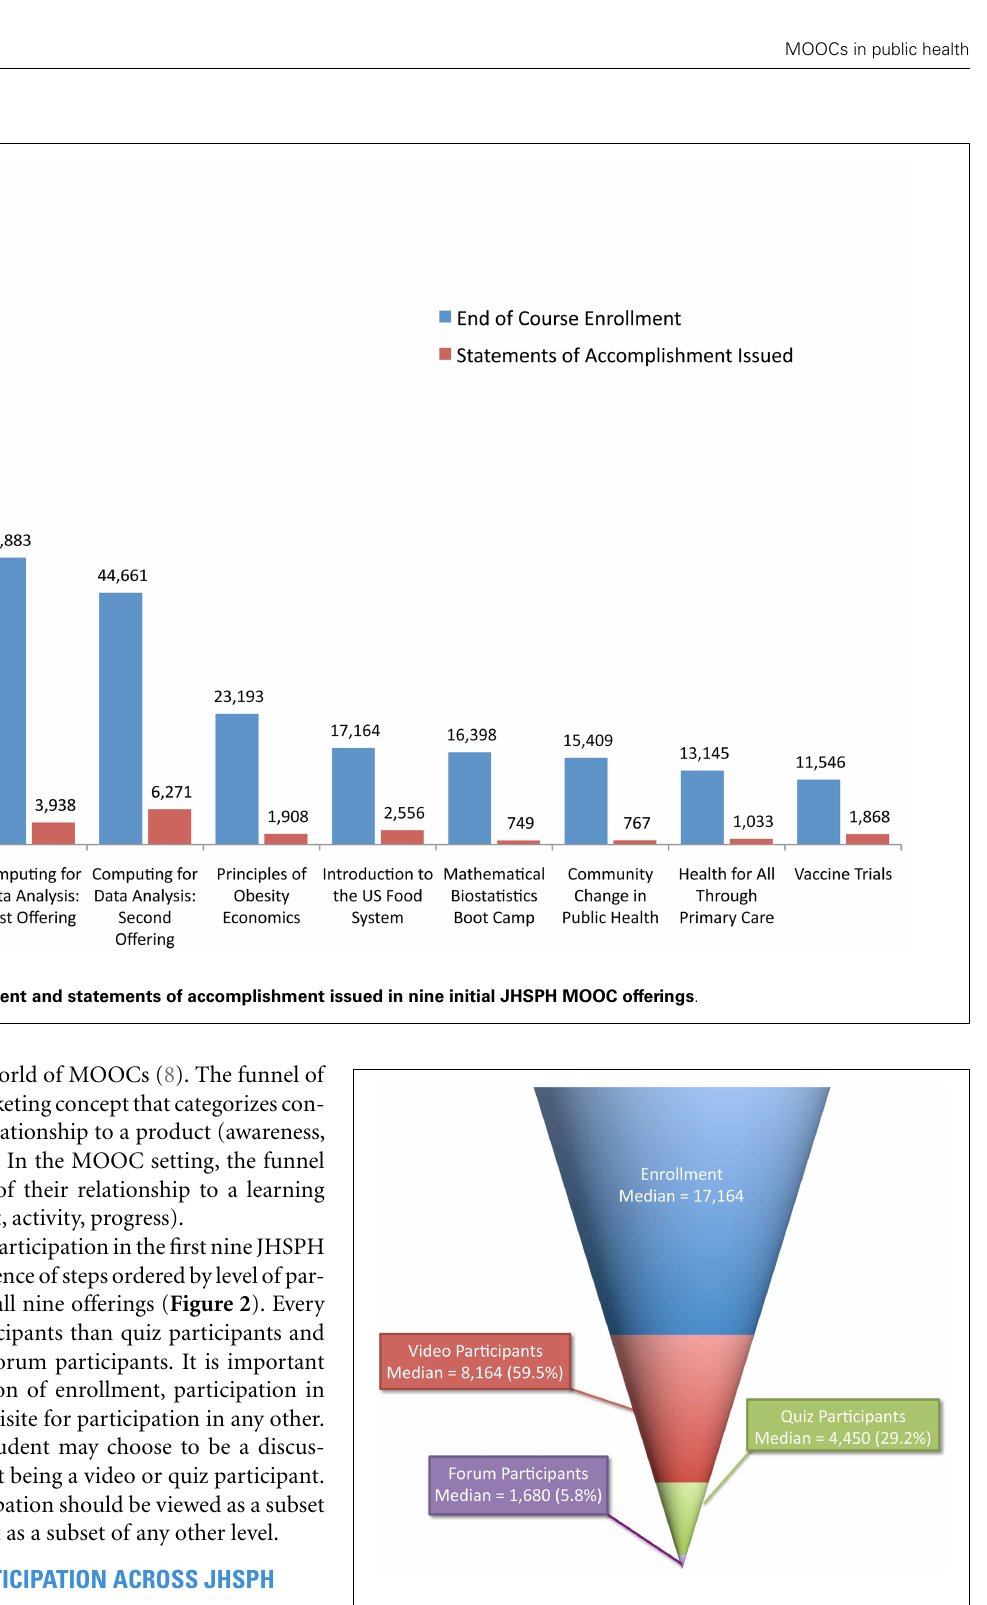
FIGURE 2 | Funnel of participation in nine JHSPH MOOC offerings